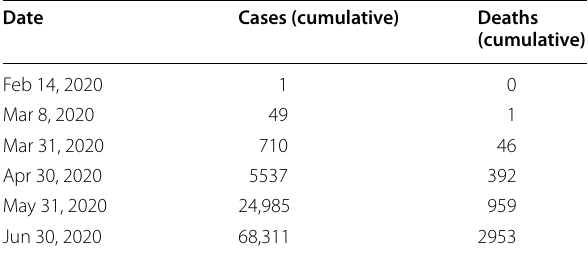
Table 1 milestone dates of the COVID-19 spread in Egypt, with the corresponding cumulative numbers of cases and deaths